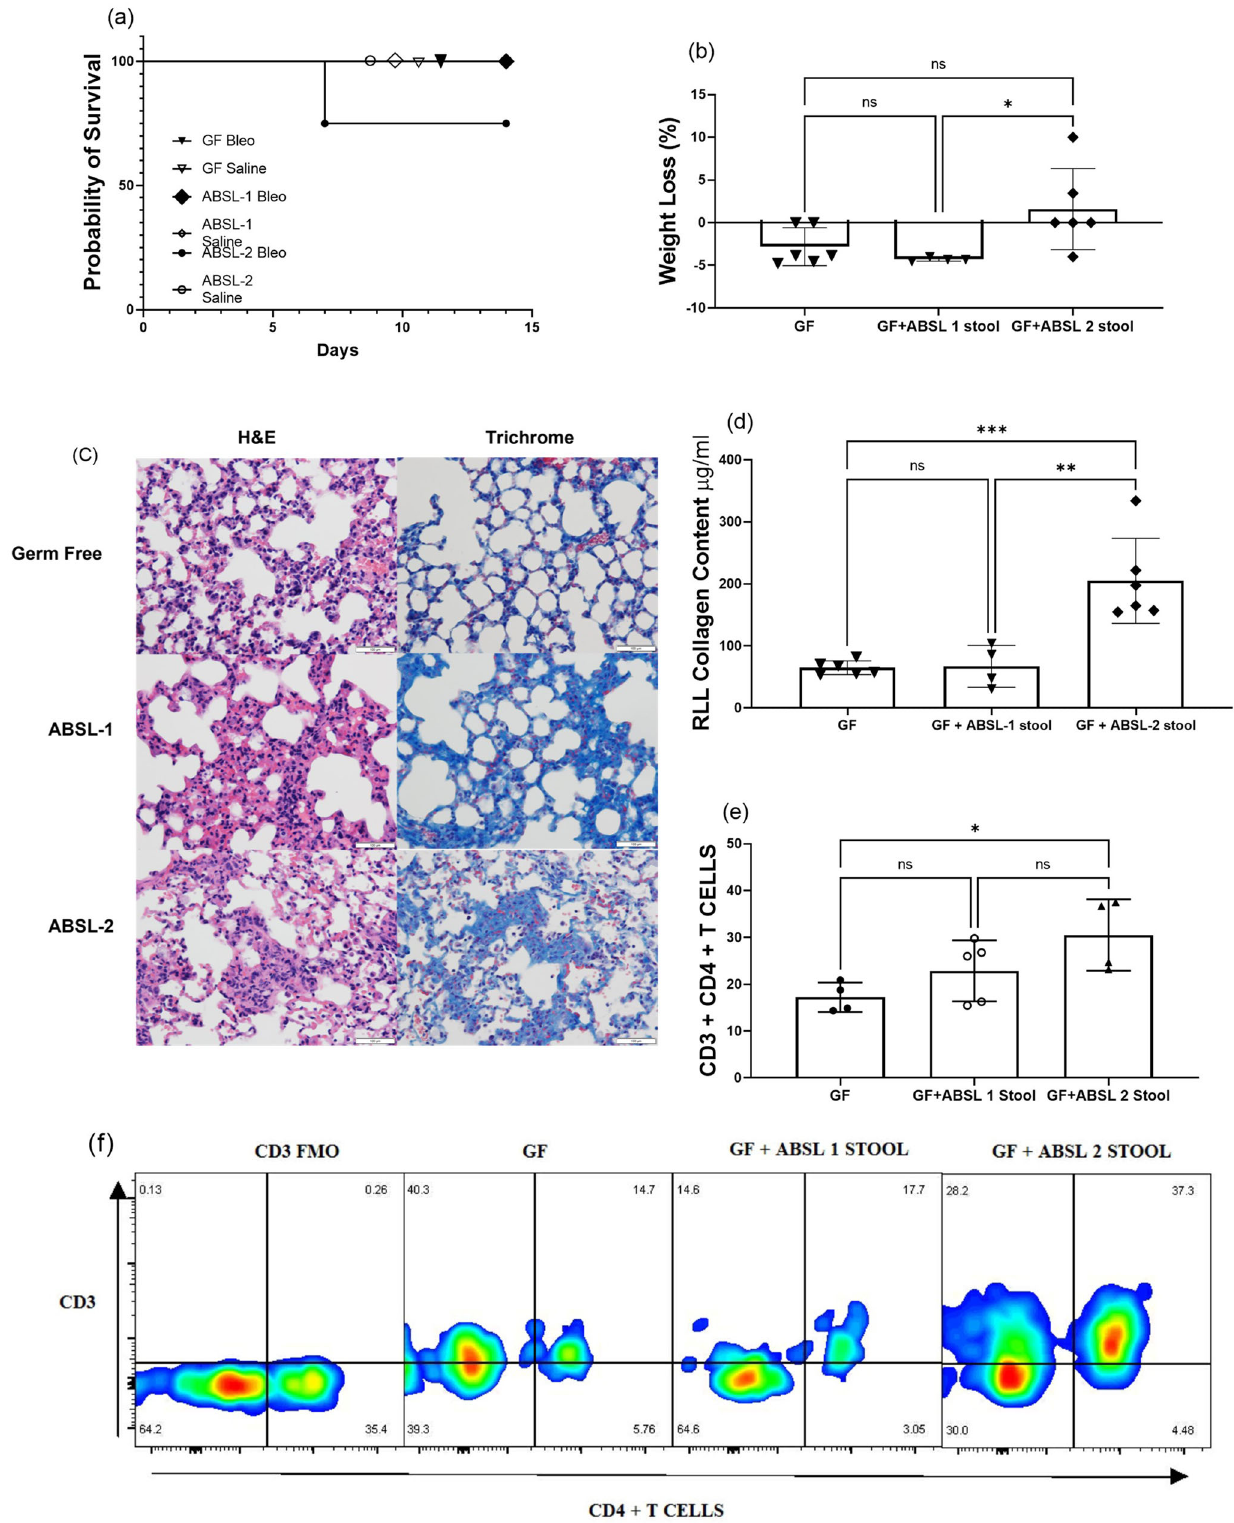
The human gut microbiota represents a thriving ecosystem with taxonomic and functional diversity within and between individuals 42 . Fecal microbiota transplantation (FMT) has been explored clinically to increase gut microbial diversity to combat complications such as those occurring after allogeneic hematopoietic stem cell transplantation 43 and Clostridium dif fi cile infection 44